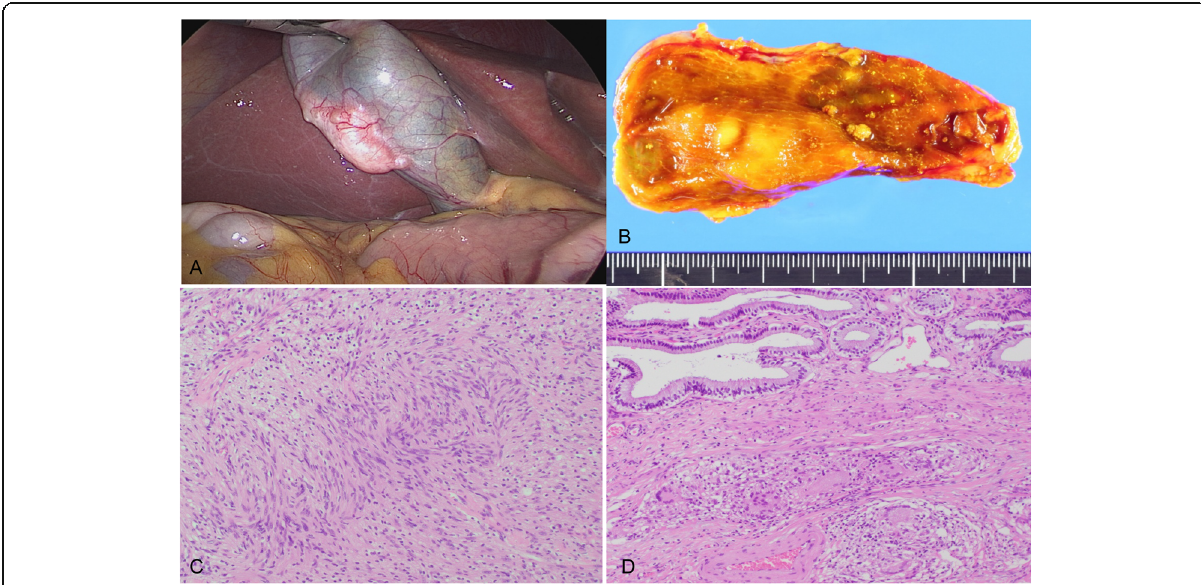
Fig. 2 a Photograph of gallbladder during laparoscopy. b Photograph of the resected specimen showing an elastic hard mass under the gallbladder serosa. c Photomicrograph of a section of the schwannoma (hematoxylin-eosin [HE] stain, × 100). d Photomicrograph of HE-stained section of the tumor showing non-necrotic granulation consistent with sarcoidosis (×